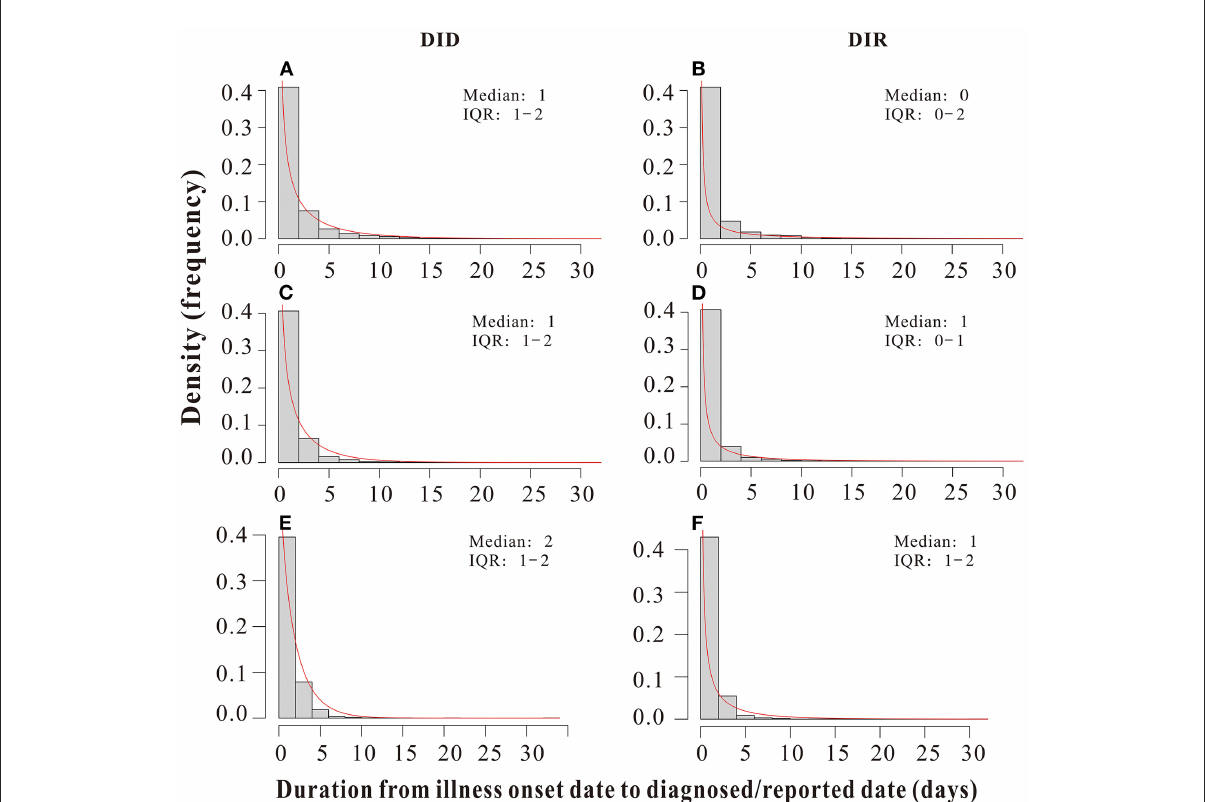
FIGURE4 Duration from the illness onset date to the diagnosed date ( D ID )/reported date ( D IR ) of all pre-Delta strains, Delta variant and Omicron variant outbreaks in China from March 28, 2020 to March 1, 2022. (A,C,E) D ID of all pre-Delta strains, Delta variant and Omicron variant outbreaks, respectively. (B,D,F) D IR of all pre-Delta strains, Delta variant and Omicron variant outbreaks, respectively.